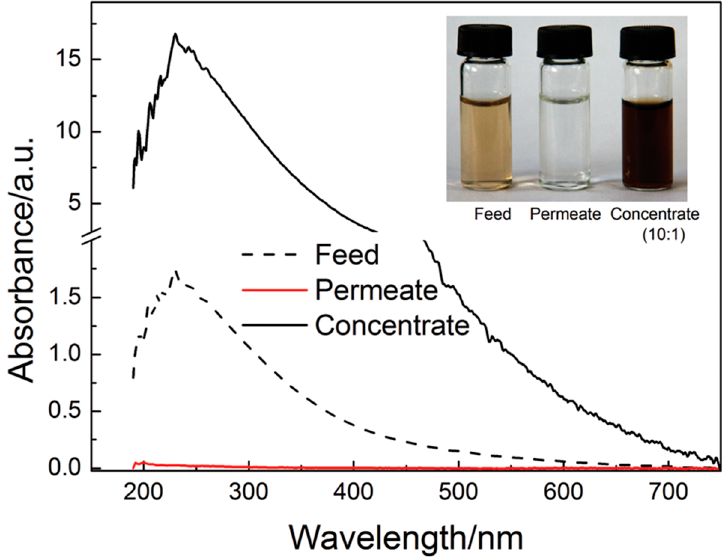
Figure 10. Performance of a reduced graphene oxide (rGO)/MWNT hybrid membrane for removing fulvic acid (initial feed concentration 50 ppm) from water. Reproduced from Reference [95] with permission from the Royal Society of Chemistry.